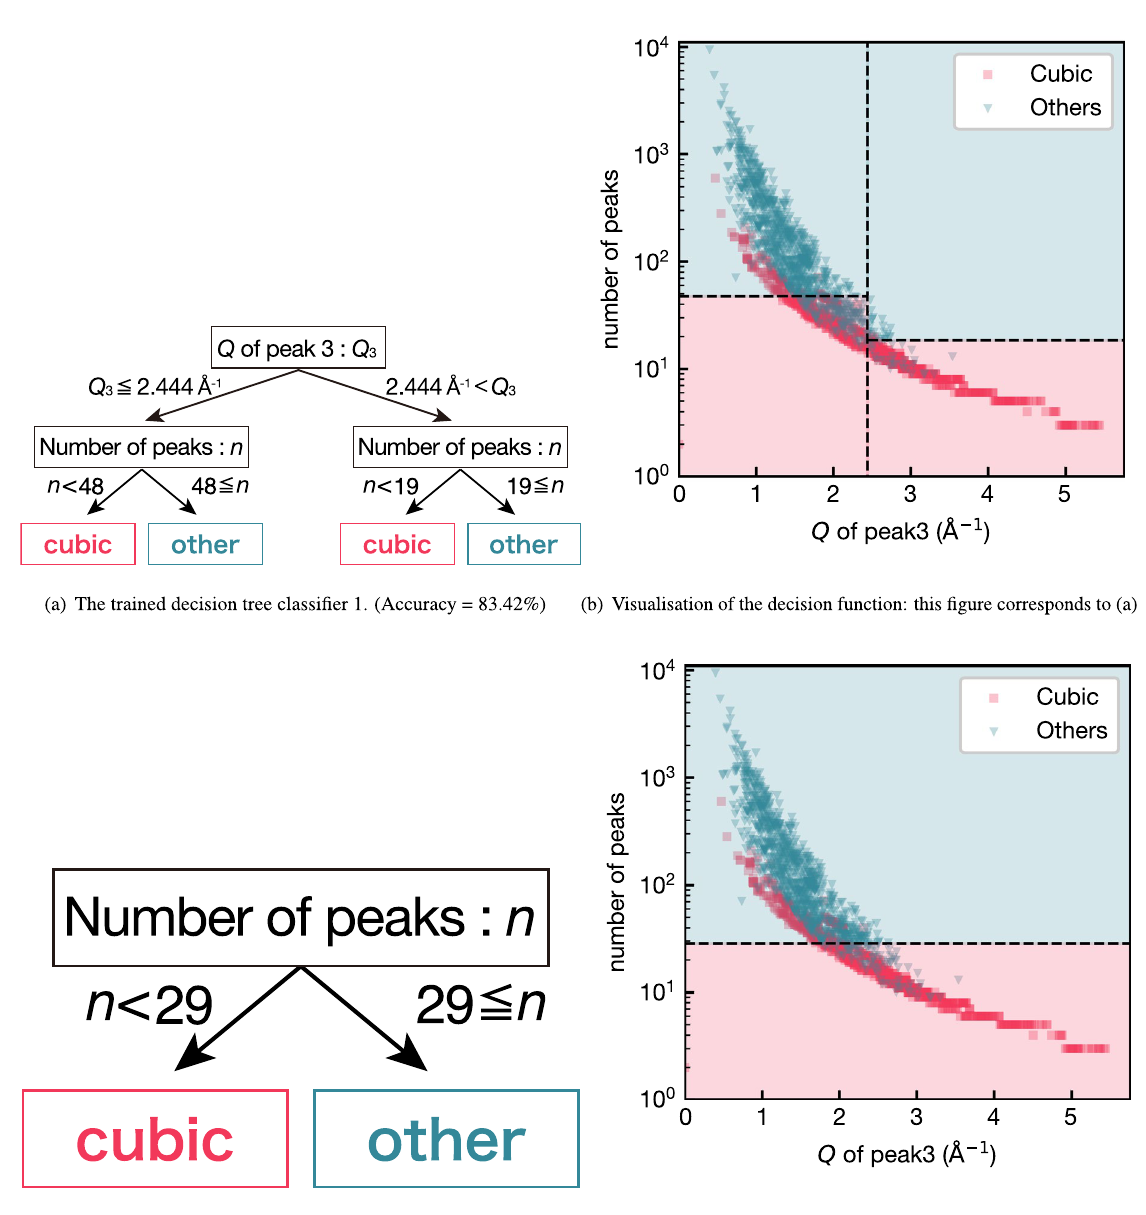
represented by the length of the scattering vector Q for